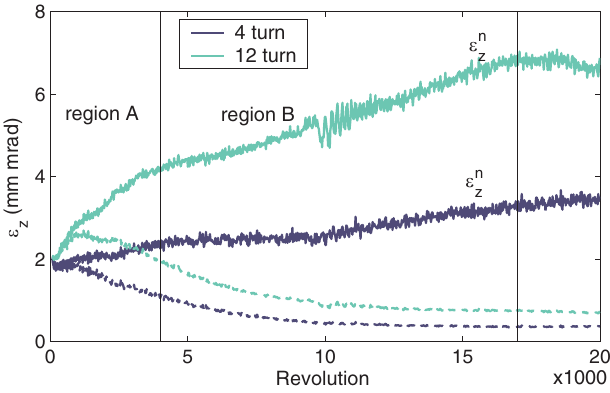
FIG. 7. (Color) The vertical rms emittance (dashed) and the normalized rms emittance (solid) in the entire cycle for 4-turn and 12-turn injection.